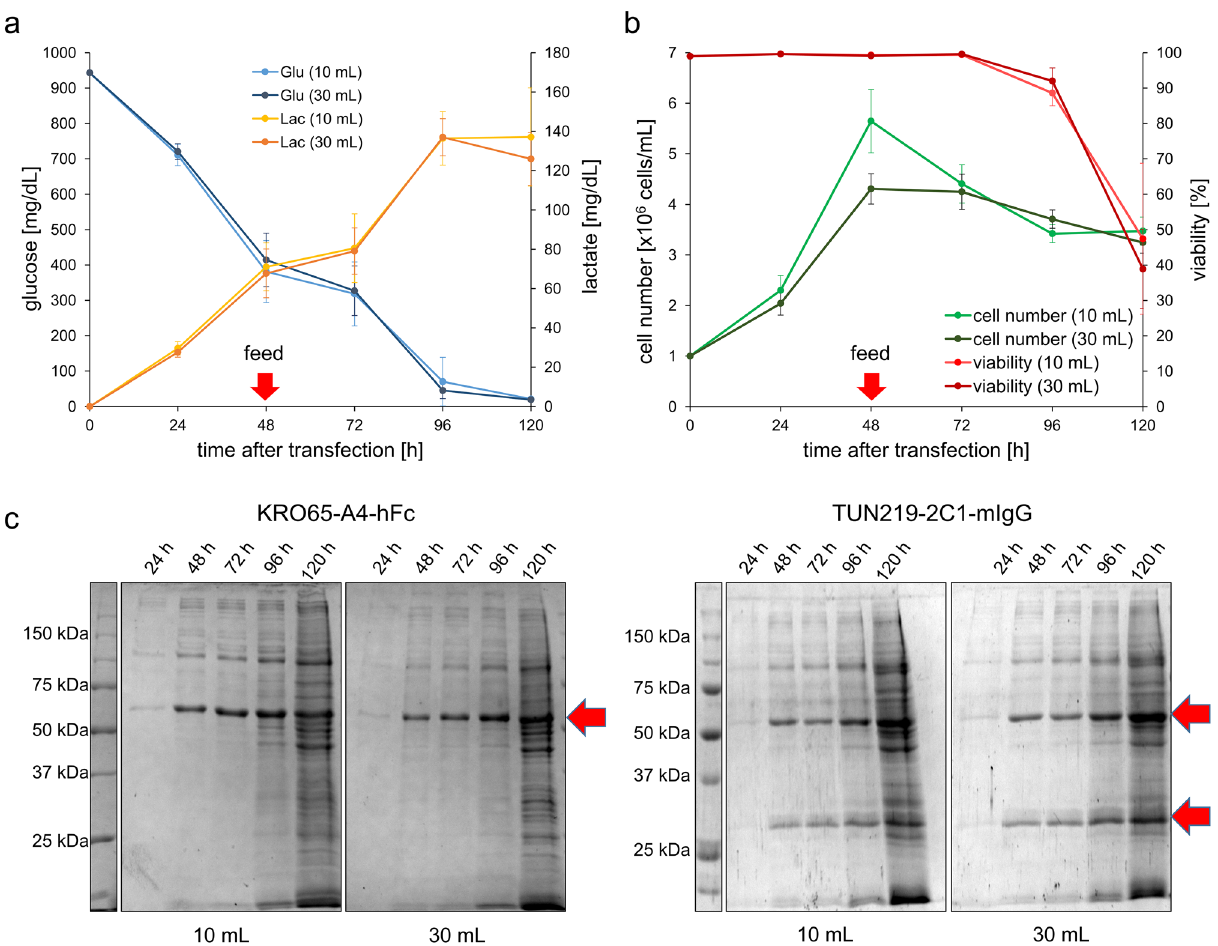
Figure 2. Cultivation parameters over 120 h. ( a ) Average Glucose and Lactate concentration in the media and ( b ) cell number and viability over time of IgG and scFv-Fc production (each done three times). ( c ) SDS–PAGE of the supernatant at the indicated days of the different production scales (10 mL or 30 mL) of KRO65-A4-hFc (~ 52.9 kDa) and TUN219-2C1-mIgG (Heavy chain ~ 51.5 kDa, light chain ~ 24.1 kDa). In total three SDS– PAGEs were grouped together for this figure, the original SDS–PAGEs are shown in Supplementary Data